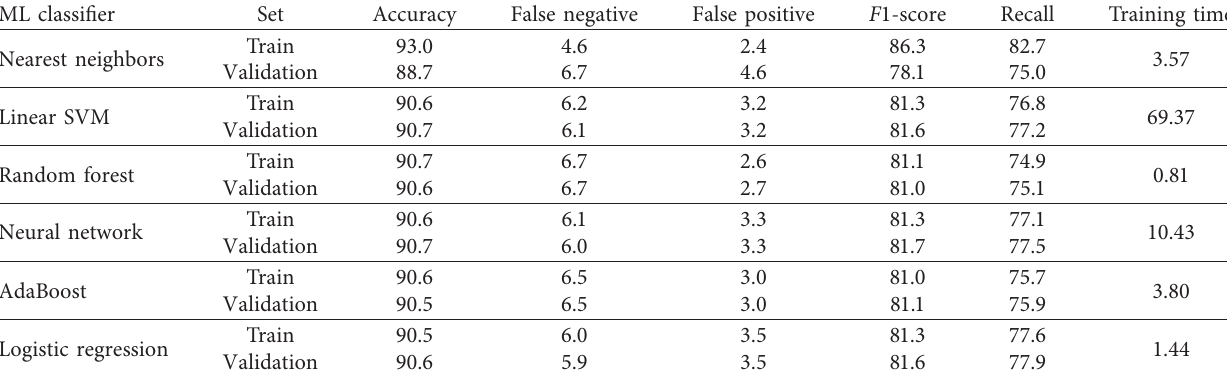
Table 2: Machine learning classifiers performance with TH � 50 for the FD001